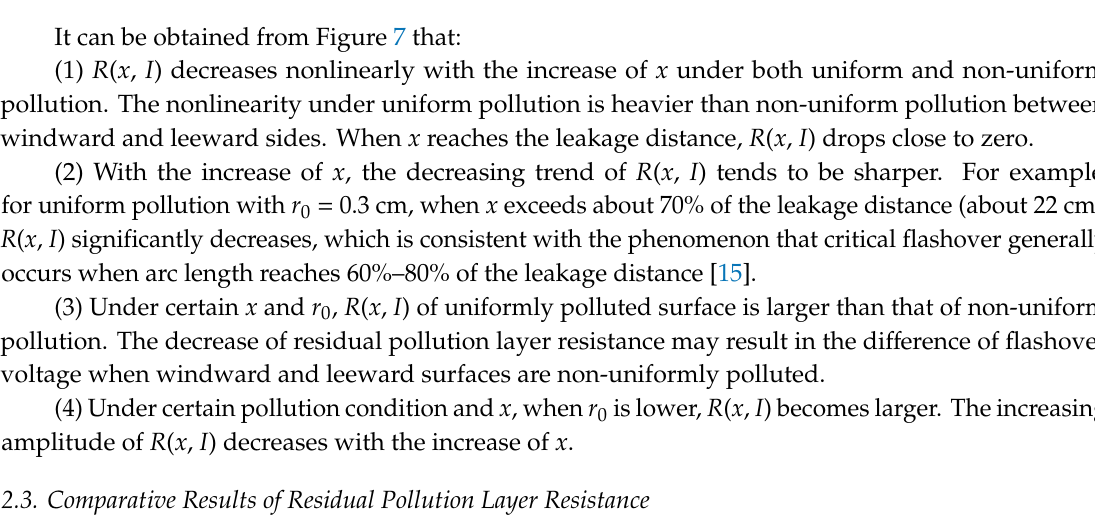
Figure 7. Relationship between residual pollution layer resistance and arc length.